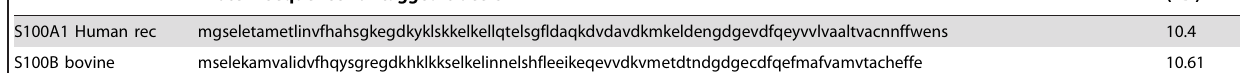
Protein sequence for tagged